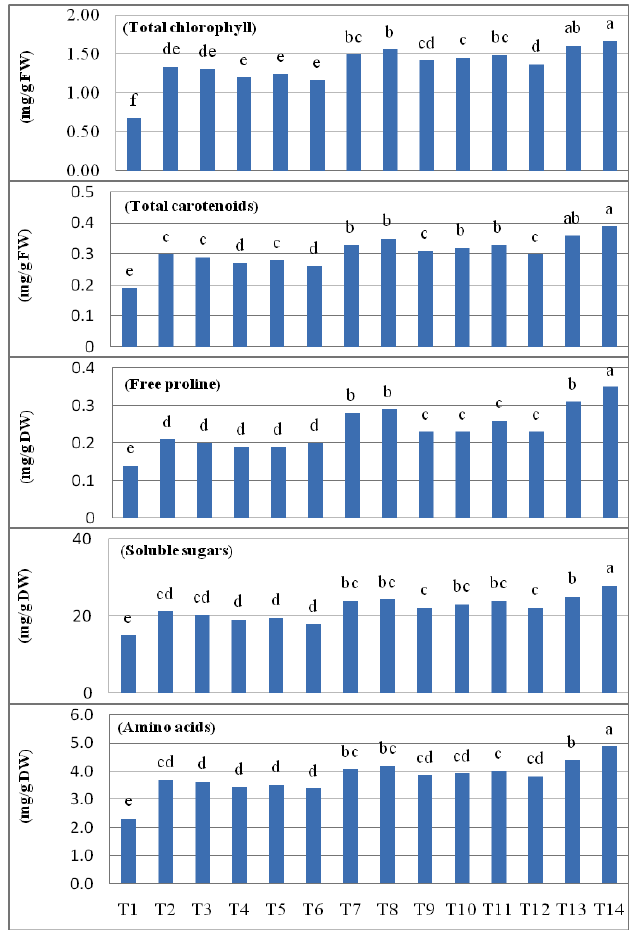
Fig. 1: Effect of N-fertilizer form applications on the leaf concentrations of total chlorophyll, total carotenoids, free proline, total soluble sugars, and amino acids in wheat plants grown under saline soil conditions. * Mean values are presented in form of vertical bars. Bars with a dif- ferent lower-case-letter are significantly different by Fisher’s least- significant difference test (LSD) at P ≤ 0.05. T 1 : Control (without any N-fertilizer); T 2 : Recommended N as ammonium nitrate (160 kg N = 476 kg NH 4 NO 3 ha -1 with 33.5% N); T 3 : Recommended N as Urea (160 kg N = 348 kg ha -1 urea [(NH 2 ) 2 CO] with 46% N); T 4 : Poultry manure (PM 1 = 10 t ha -1 ); T 5 : Cattle manure (CM 1 = 20 t ha -1 ); T 6 : Bio-N (Cerealine at rate of